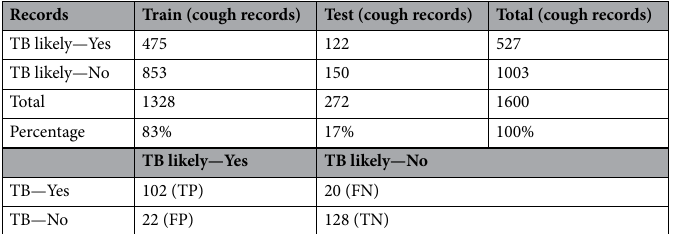
Table 3. Data distribution into train data and test data along with final confusion matrix for the test data in derivation